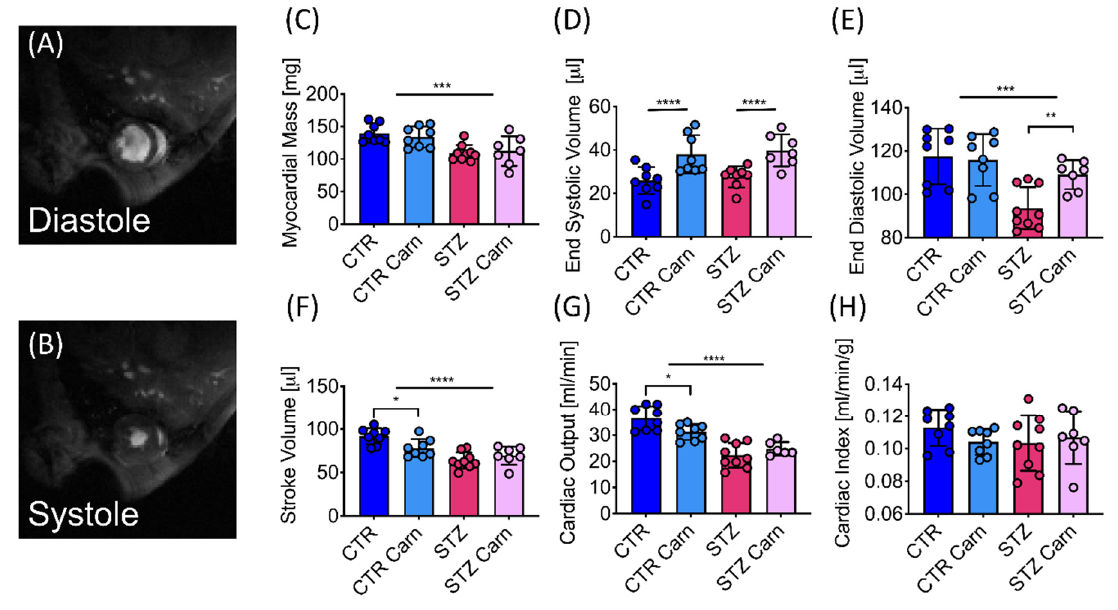
Figure 2. The diabetic heart displays reduced cardiac function on CINE magnetic resonance imaging (MRI). ( A ) Example CINE-MRI image of the rat heart in diastole. ( B ) Example CINE-MRI image of the rat heart at systole. ( C ) Average myocardial wall mass. ( D ) End-systolic volume (ESV). ( E ) End-diastolic volume (EDV). ( F ) Stroke volume (SV). ( G ) Cardiac output (CO). ( H ) Cardiac index. Data are presented as mean ± SD. Two-way ANOVA, if an interaction was found to be significant, the effect of L-carnitine on control and diabetes was evaluated using Sidak’s multiple comparison test. Significant differences are represented by ‘*’, with * p < 0.05, ** p < 0.01, *** p < 0.001, **** p < 0.0001. Table 1. Cardiac function obtained from CINE-MRI. Functional parameters are normalized to body weight (BW), where stated. Data presented as mean ± SD. Two-way ANOVA. p -value displayed with the effect of streptozotocin (STZ), the effect of L-carnitine (Carn) and the interaction between the two effects.